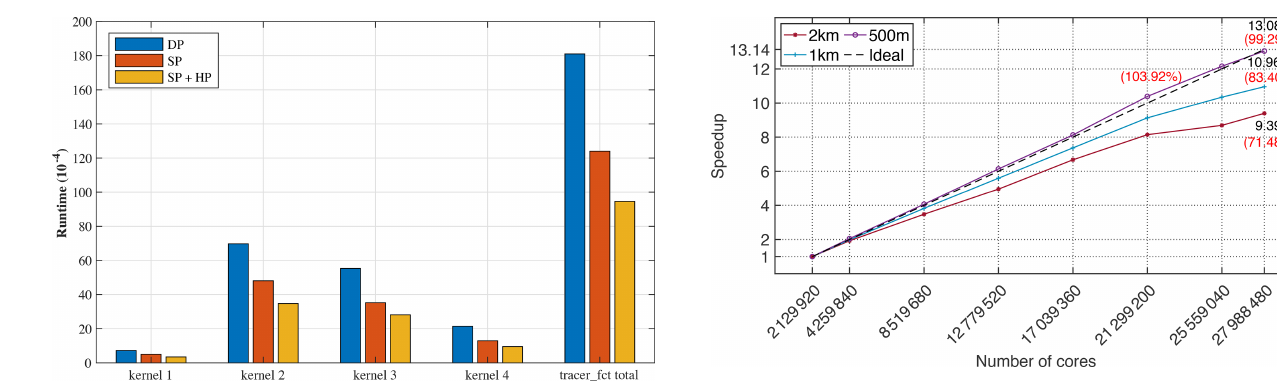
Figure 10. Time cost of the tracer_fct process.